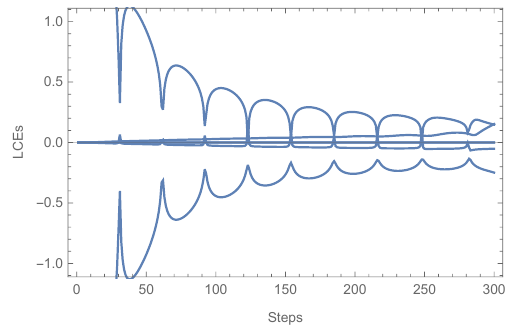
Figure 11. LCEs for the massless solution with large R 0